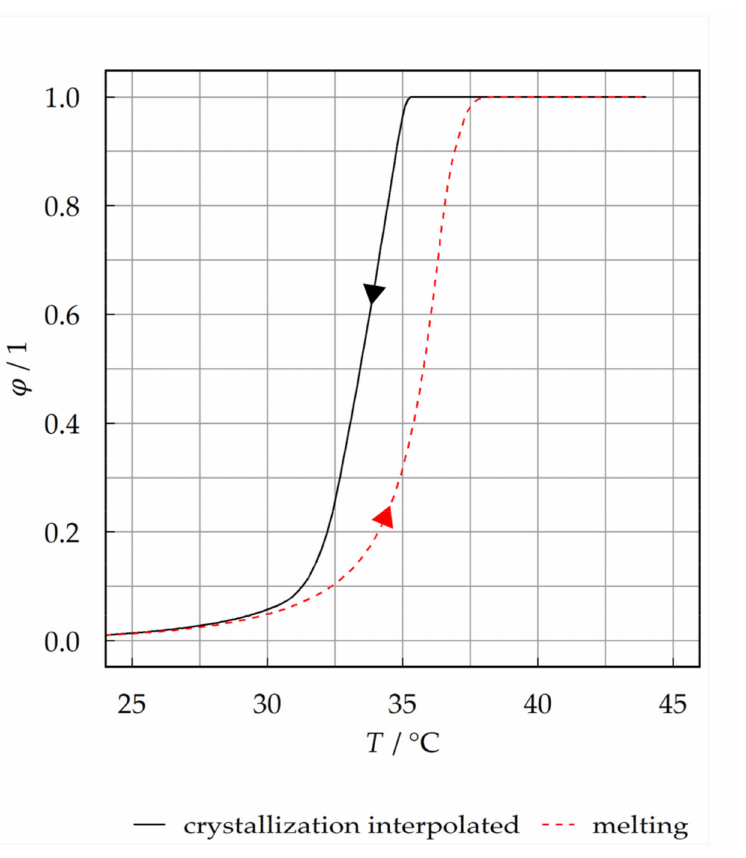
Figure 4. Phase transition function for interpolated crystallization and